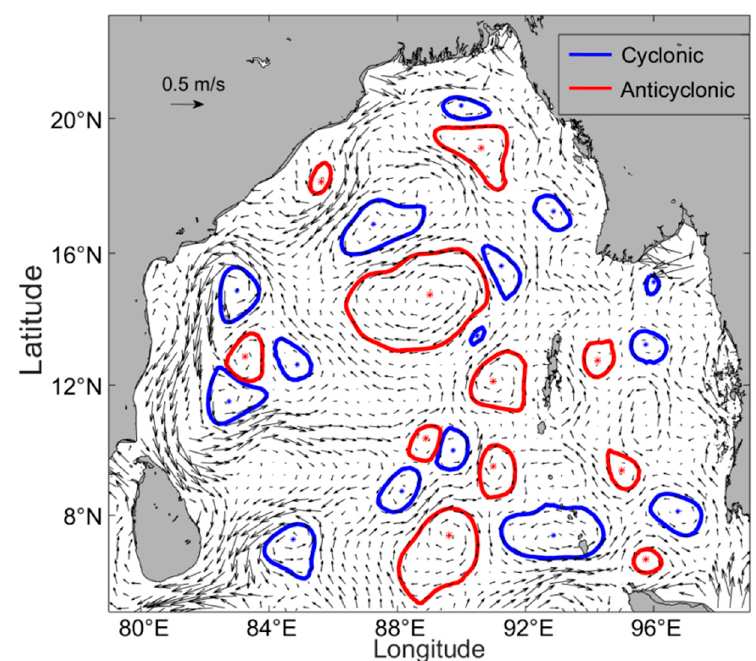
Figure 3. Snapshot of eddy distribution on 10 November 2016. Blue (red) asterisks and circles represent the centers and boundary curves of CEs (AEs). Vectors correspond to surface geostrophic velocity anomalies.